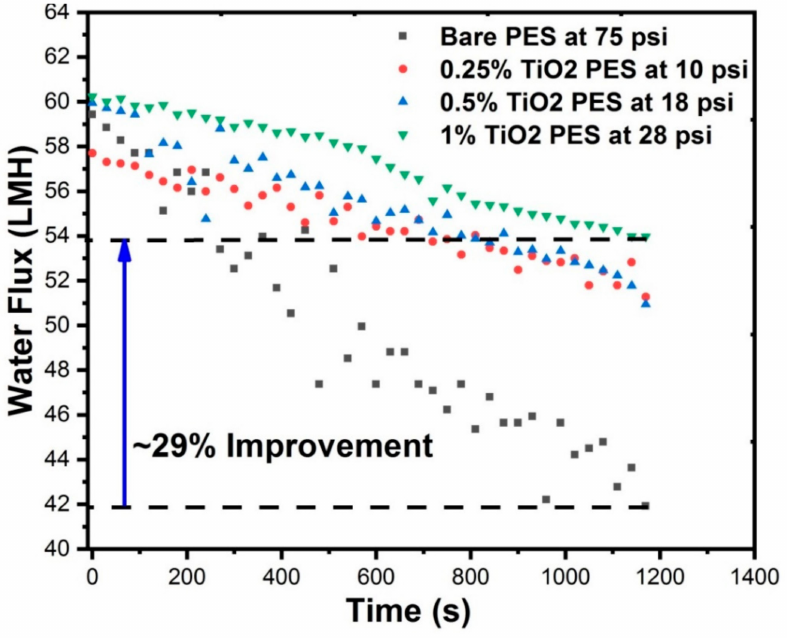
Figure 10. Water flux vs. time discrete TiO 2 nanocomposite membranes and unmodified PES membrane due to